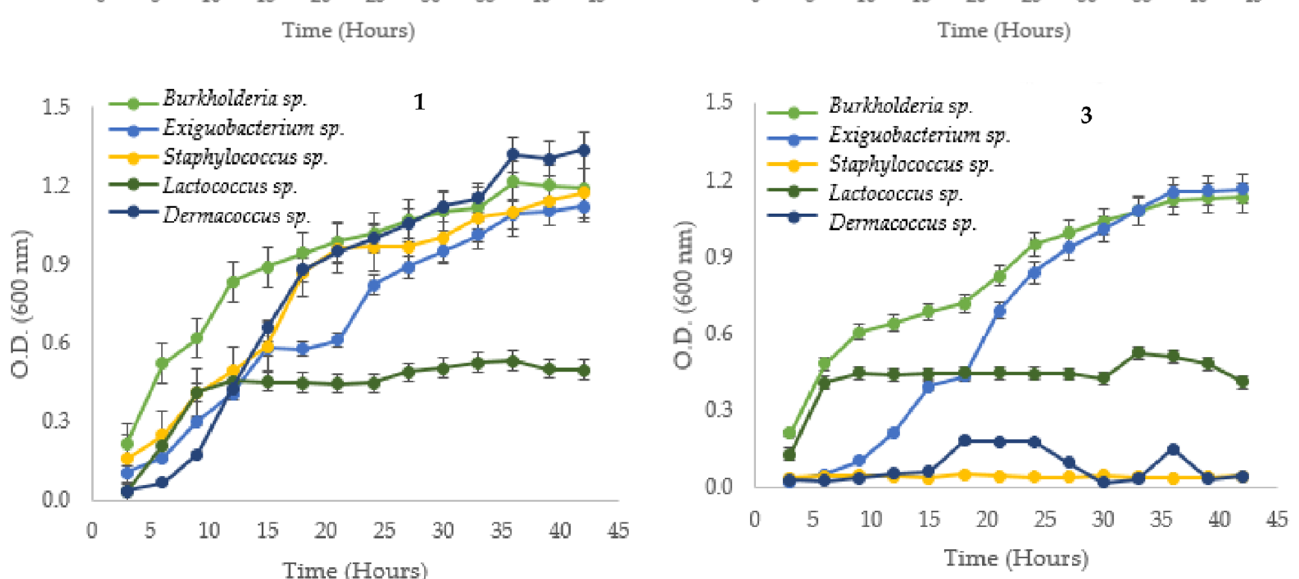
Table 2. Mean values of growth parameters with and without Cd in nutrient broth.